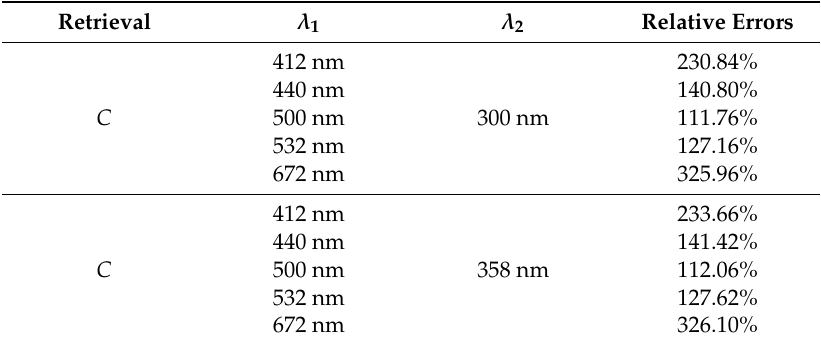
Table 2. Minimum errors when fixing λ 1 and changing λ 2 under Case 1 in Table